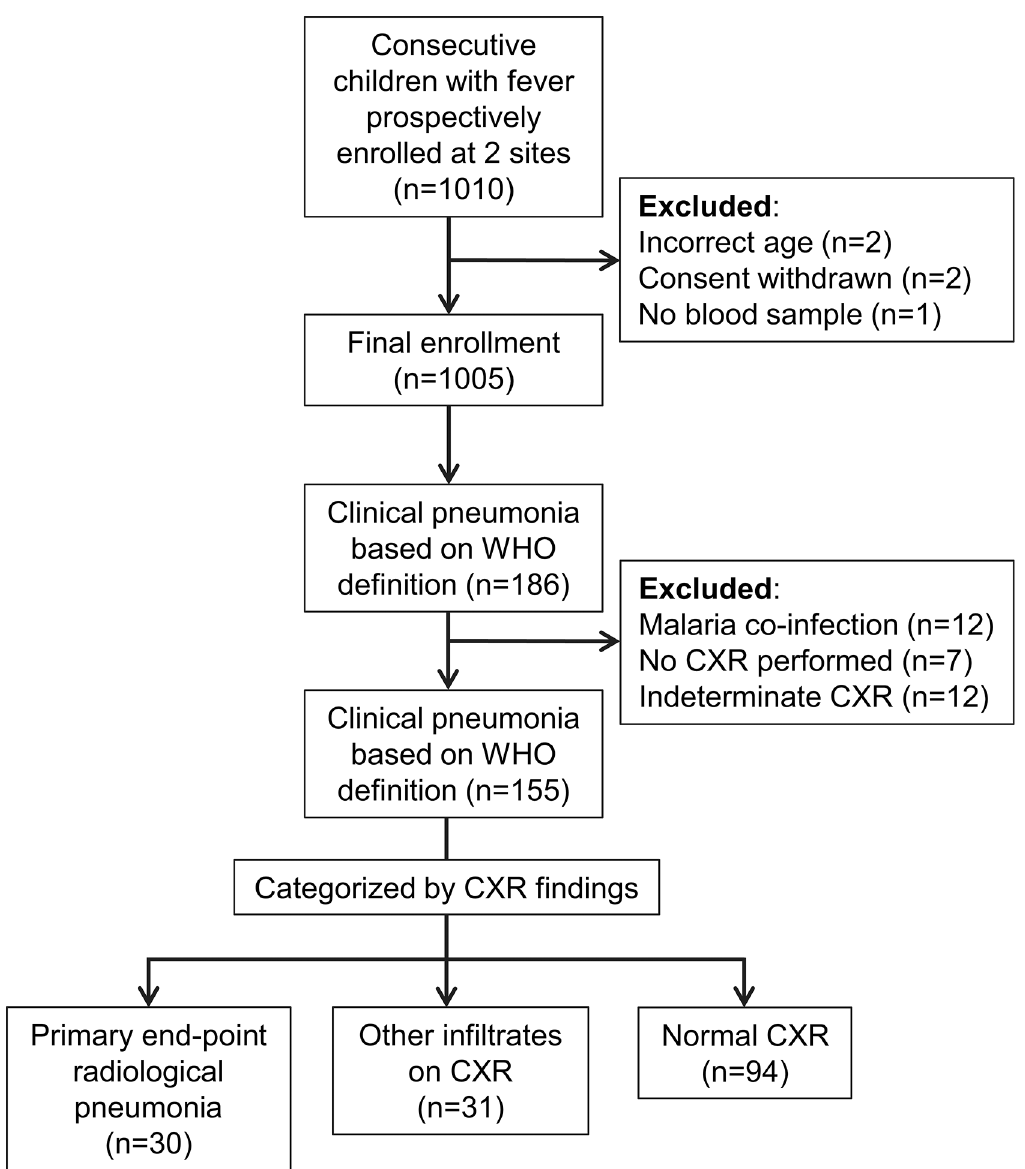
Fig 1. Description of study population. This study was nested in a prospective fever etiology study conducted at the outpatient clinics of two district hospitals in Tanzania. The clinics function as primary care centres for local children. Children presenting with fever were enrolled consecutively, and clinical evaluation and investigations were performed according to pre-defined questionnaires and algorithms. Children with WHO-defined clinical pneumonia were included in the present study, with exclusions as illustrated, and categorized according to findings on chest x-ray (CXR): WHO-defined primary end-point pneumonia, other infiltrates, or normal